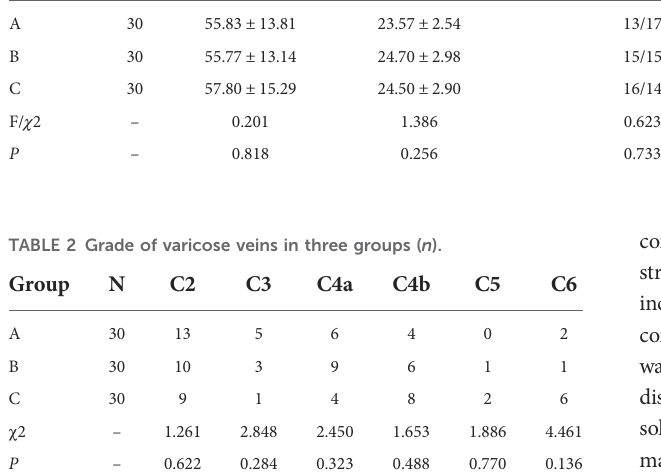
Nerve blockers: 20 ml of normal saline, 20 ml of 2% ropivacaine and 200 mg of lidocaine injection.